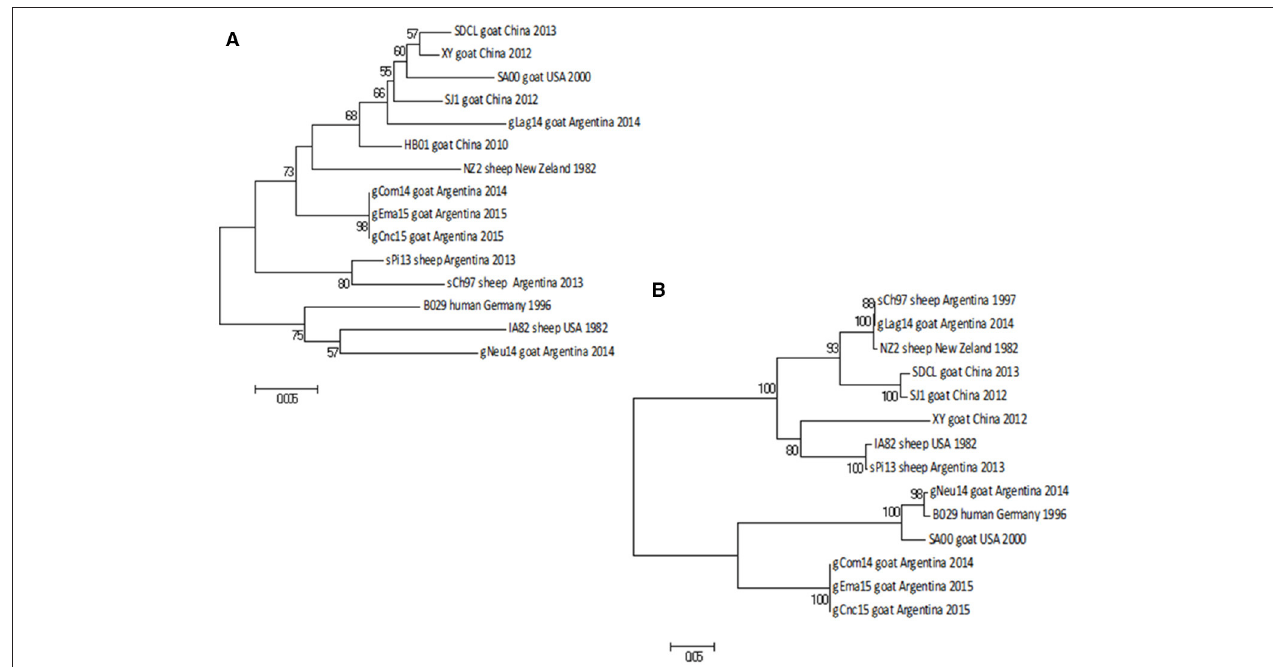
FIGURE 6 | Phylogenetic analysis based on nucleotide sequence of orf127 and orf109 . The phylogenetic relationship was constructed by the Neighbor-Joining algorithm using MEGA 6.0 software. Numbers at nodes represent % of one thousand bootstrap replicates. The scale bars are expressed in relative nucleotide sequence difference. (A) NJ tree based on orf127 was obtained with Kimura-2P evolution model. (B) NJ based on the sequence of orf109 was obtained with Tamura-3P evolution model.